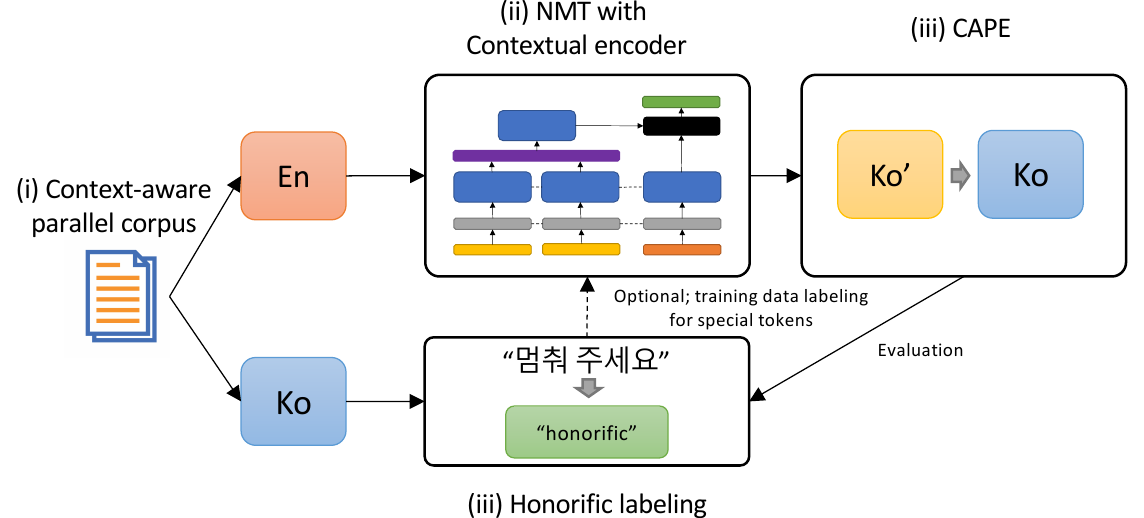
Figure 5. The process of our method, context-aware NMT for Korean honorifics. First we train NMT model with contextual encoder for English-Korean and Korean-English translation. Then we train CAPE to correct errors on those round-trip translations made by the NMT model. The automatic honorific labeling is primarily used for assessing honorific translation, but can also be used to label the training set if the NMT model uses special tokens to control target honorifics